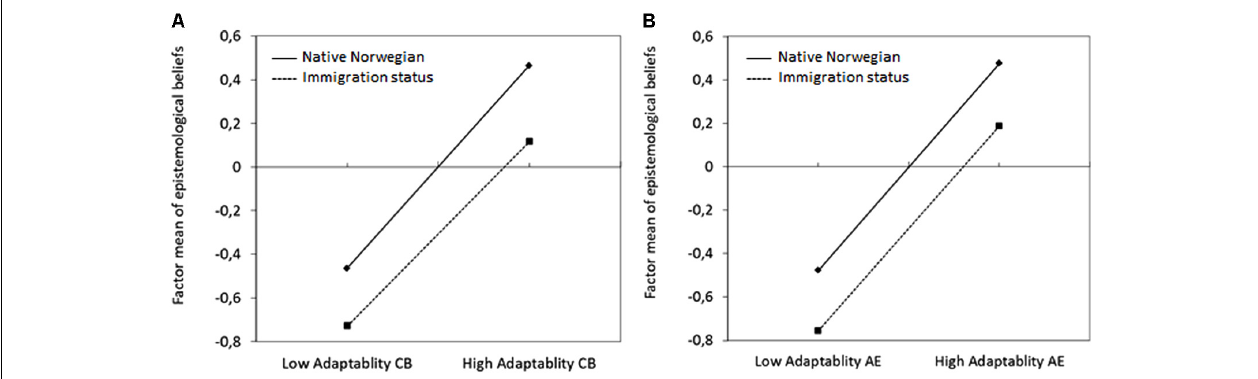
FIGURE 3 | Interaction effects between students’ immigration status and (A) cognitive-behavioral adaptability (CB) and (B) affective-emotional adaptability (AE) on the factor mean of epistemological beliefs in the development of scientific